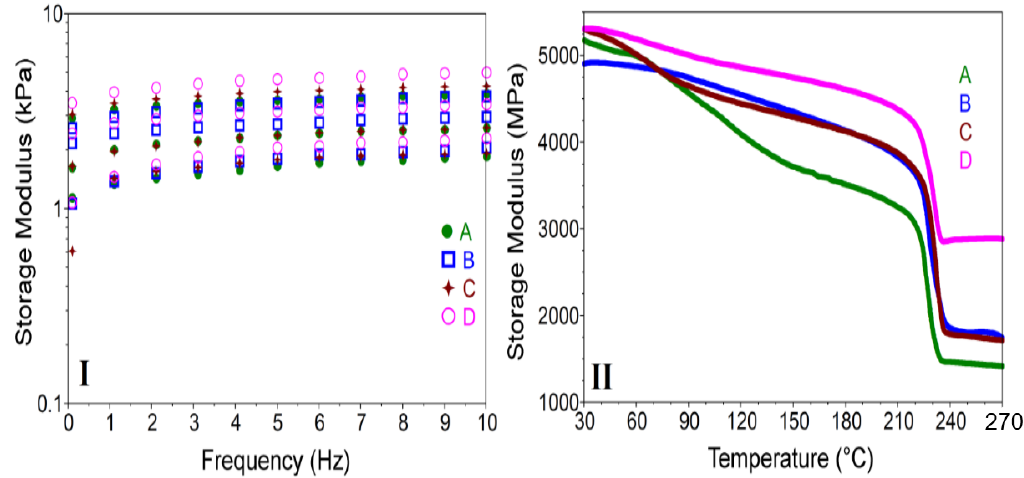
Figure 6. DMA results registered for pure PMAA ( A ) and PMAA-Cl 93A ( B ), PMAA-Cl 93A-C8 ( C ), PMAA-Cl 93A-C18 ( D ) nanocomposites; Storage modulus as function of: I . Frequency; II . Temperature.